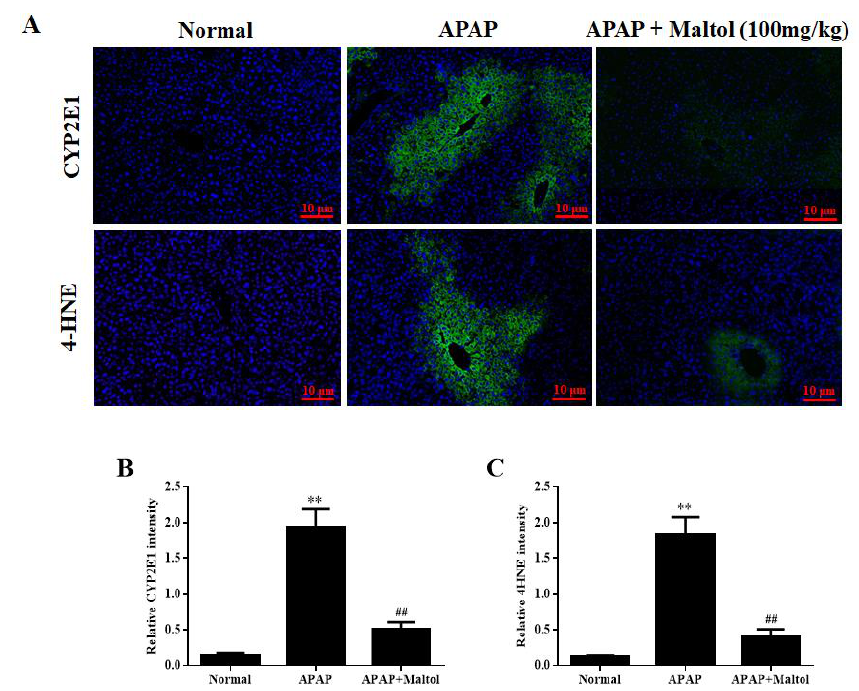
Figure 2. ( A ) Effects of maltol pretreatment on the expression of cytochrome P450 E1 (CYP2E1) and 4-hydroxynonenal (4-HNE) in liver tissues. The expression levels of 4-HNE and CYP2E1 (green) were determined by immunofluorescence (magnification ×200), and nuclear counterstaining (blue) was performed by 4, 6-Diamidino-2-phenylindole (DAPI). Quantitative fluorescence intensities of CYP2E1-positive cells ( B ) and 4-HNE-positive cells ( C ). All data are expressed as mean ± S.D.; n = 8. ** p < 0.01 vs. normal group; ## p < 0.01 vs. APAP group.